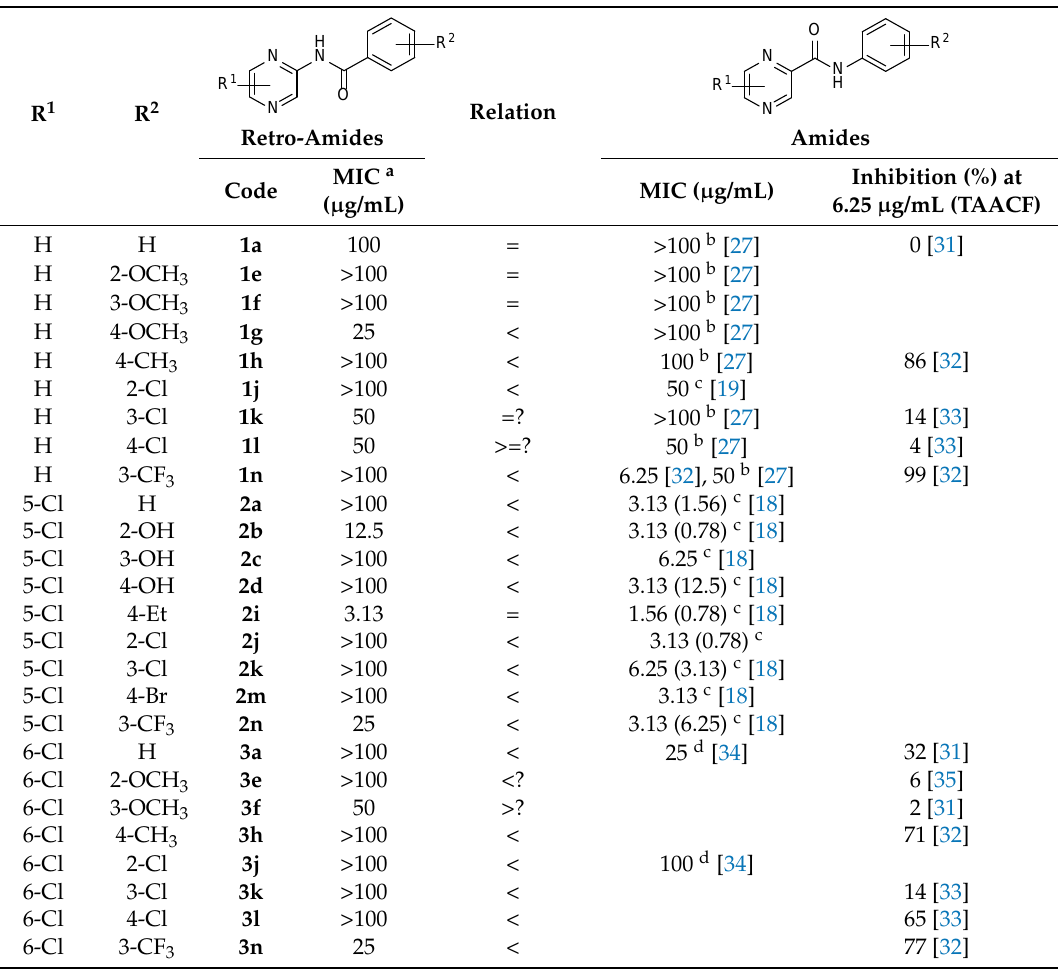
Table 6. Comparison of antimycobacterial activity ( Mtb ) of prepared N -pyrazinylbenzamides (retro-amides) with corresponding N -phenylpyrazine-2-carboxamides (amides).